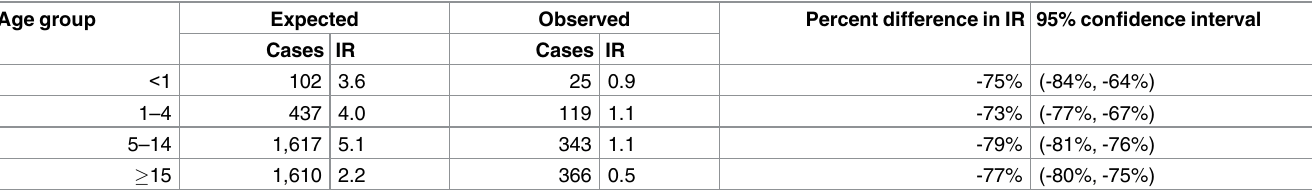
Table 2. Japanese encephalitis expected and observed cases and incidence rates (IR) per 100,000person yearsby age group in Nepal.